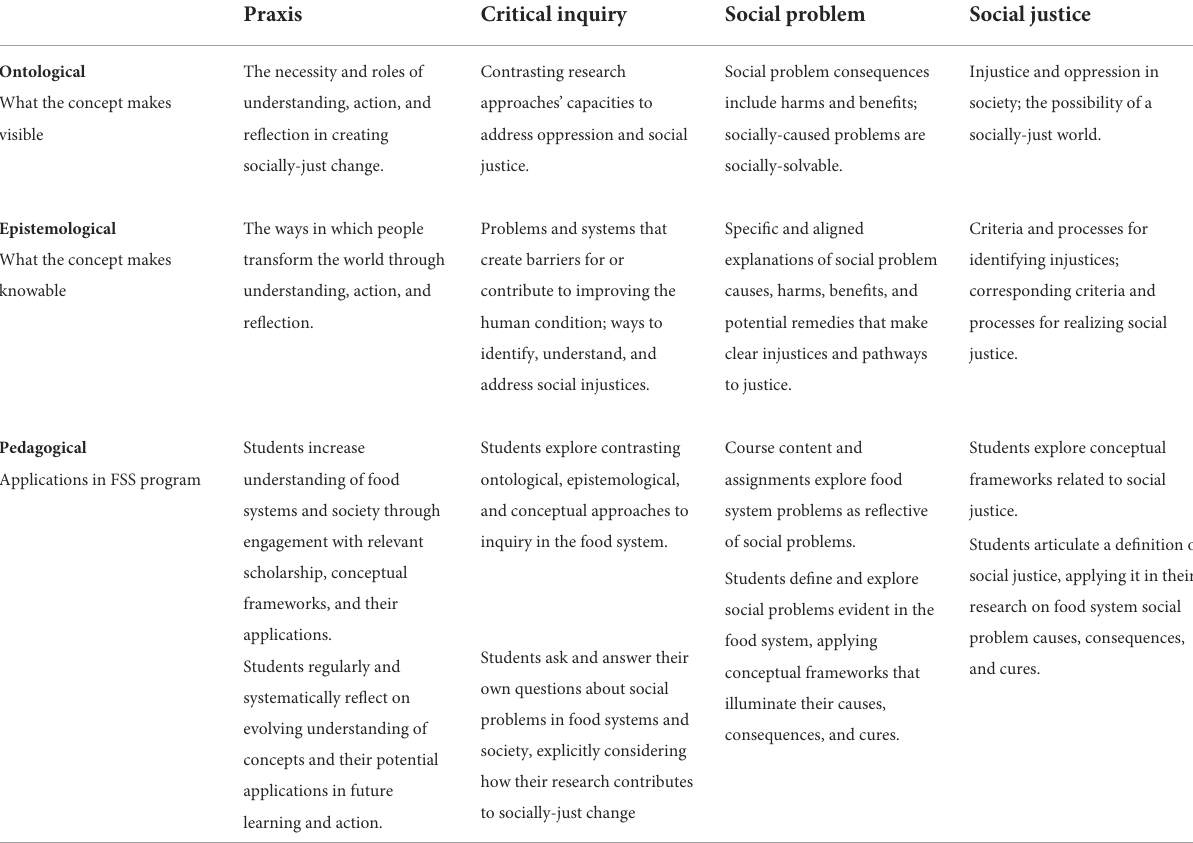
TABLE 1 Ontological, epistemological, and pedagogical foundations of the food systems and society graduate